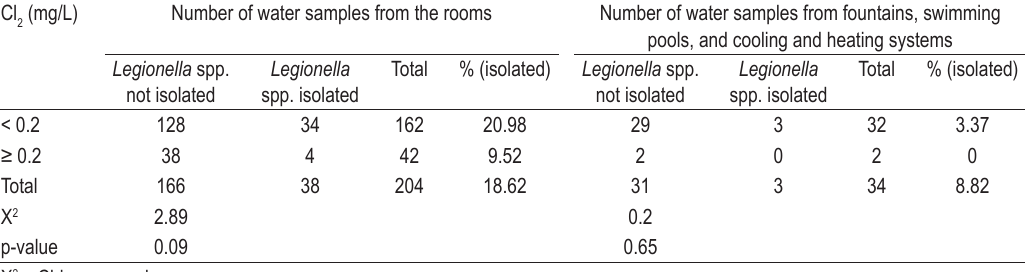
pools, and cooling and heating systems